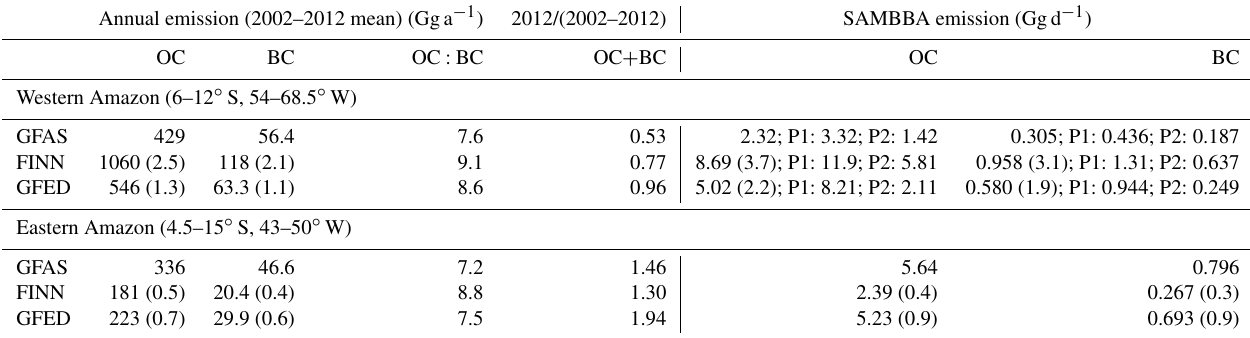
Table 1. Comparison of organic carbon (OC) and black carbon (BC) emissions from biomass burning in the GFASv1.2, FINNv1.5 and GFED4.1s emissions inventories. Emissions are summed separately for the western (6–12 ◦ S, 54–68.5 ◦ W) and eastern (4.5–15 ◦ S, 43– 50 ◦ W) Amazon, as shown in Fig. 2. The table reports long-term (2002–2012) mean annual total emissions, the ratio of annual total emissions in 2012 to the 2002–2012 mean and total emissions for the SAMBBA campaign period (13 September–3 October 2012). All values are given to at least three significant figures. The ratios (FINN : GFAS and GFED:GFAS) of total annual emissions during the 2002–2012 period and mean daily emissions during the SAMBBA campaign are given in parentheses. For the western Amazon, daily emissions are also shown for the two phases of the campaign: P1 (13–22 September) and P2 (23 September–3 October). Annual emission (2002–2012 mean) (Gga − 1